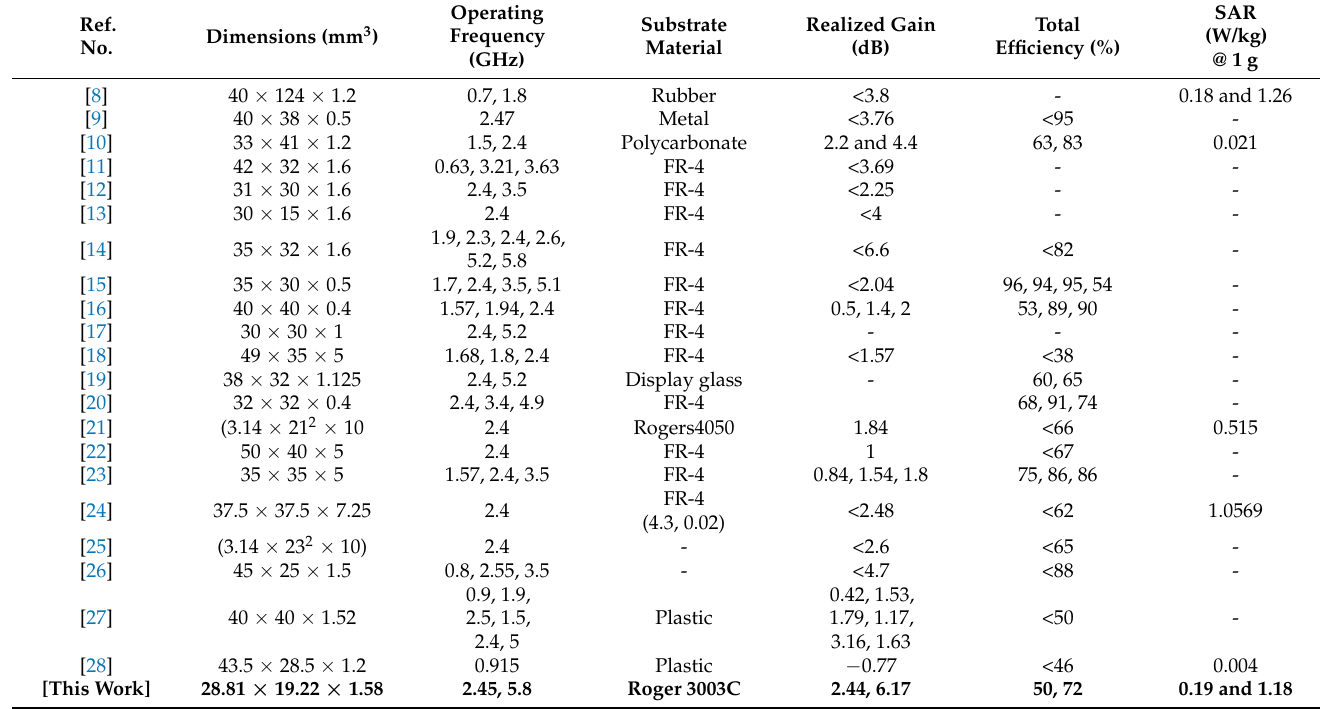
Table 5. Comparison of this work with previous